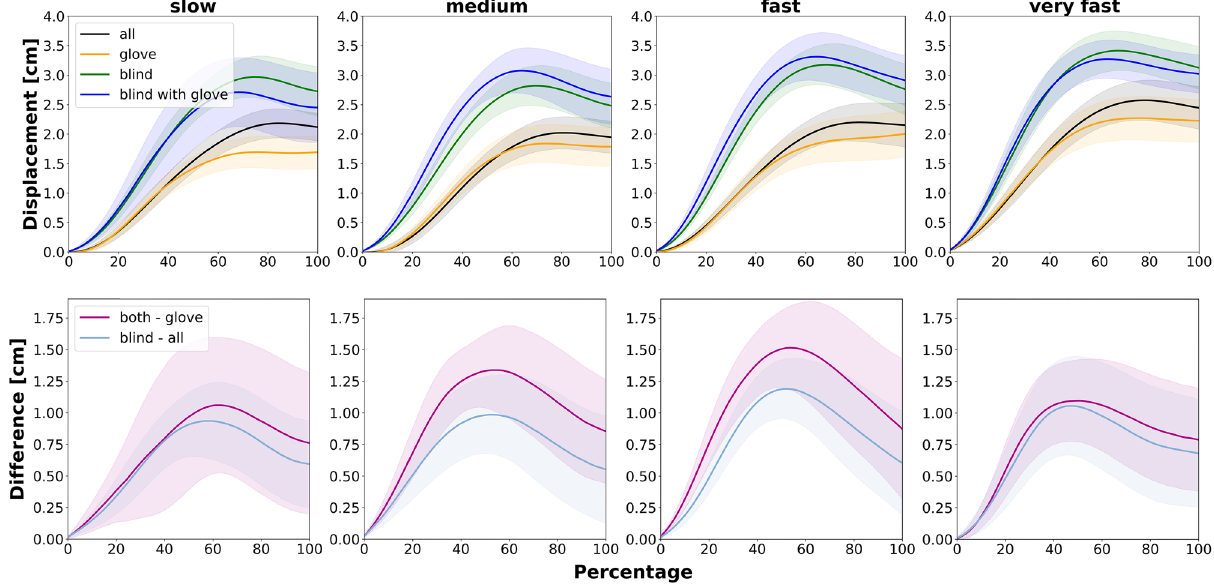
Figure 3. Kinematic profiles showing the object movement in the vertical direction during the handover phase (upper row). The profile begins at the moment of initial receiver contact (0%) and ends with the last contact of the passer (100%). Height values were baseline corrected to the object height shortly before the receiver’s initial contact with the object. The profiles in the lower row show the isolated effects the visual restriction. Error-bands show 95% confidence interval by PBRT algorithm.